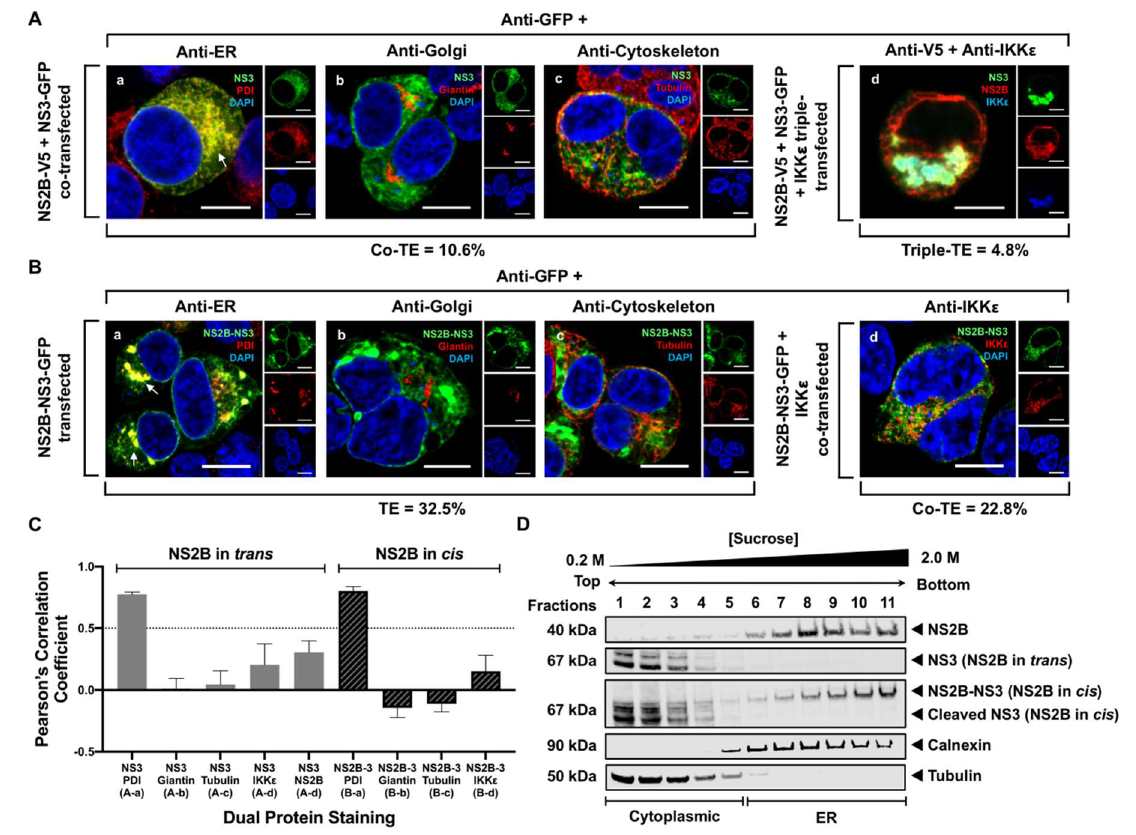
Figure 3. NS3 localizes to the ER when NS2B is provided in trans and in cis. ( A ) HEK293T cells were co-transfected with NS3-GFP and NS2B-V5 expressing plasmids ( a – c ). At 24 h post-transfection, cells were fixed and co-stained with anti-GFP and antibodies against PDI (red; a ), giantin (red; b ) or tubulin (red; c ). HEK293T cells were also triple-transfected with NS3-GFP, NS2B-V5/His and IKK ε -FLAG expressing plasmids ( d ) and triple stained with anti-GFP (green; d ), anti-V5/His (red; d ) and anti-IKK ε (blue; d ) antibodies. ( B ) HEK293T cells were transfected with NS2B-NS3-GFP ( a – c ) or co-transfected with NS2B-NS3-GFP and IKK ε -FLAG expressing plasmids ( d ) and processed for immunofluorescence at 24 h after transfection using antibodies against PDI (red; a ), giantin (red; b ), tubulin (red; c ) and IKK ε (red; d ). The detected viral and host proteins are listed on the top right corner of each panel. White arrows indicate colocalization between the GFP-tagged viral protein and the ER marker. Nuclear DNA was labeled with DAPI. Scale bar represents 10 μm. The main panels depict merged images with the side panels showing the individual channels. The transfection efficiency (TE), the co-transfection efficiency (Co-TE) and the triple-transfection efficiency (Triple-TE) for cells expressing one, two, or three gene constructs, respectively, are listed at the bottom of the panel. Images are representative of two independent transfection experiments. ( C ) Quantitation of colocalization between NS3 and cellular markers when NS2B is provided in trans (gray bars) or in cis (diagonally striped bars) was determined using the Pearson’s correlation coefficient (PCC). Letters in parenthesis underneath each pair of proteins indicate its corresponding confocal image in Figure 3A or 3B. PCC values greater than 0.5 (dotted line) indicate a high level of colocalization. Error bars indicate mean ± SEM; n = 5–10 cells per group. (D) HEK293T cells expressing both NS3-V5 and NS2B-GFP with NS2B provided in trans or cells expressing NS2B-NS3-GFP with NS2B provided in cis were lysed 48 h post-transfection and subjected to sucrose density gradient ultracentrifugation. Aliquots of fractions collected from the top of the gradient were analyzed by Western blotting. Rabbit anti-tubulin and anti-calnexin antibodies were used to distinguish between the cytoplasmic and ER fractions, respectively, and antibodies against the fused tag (GFP or V5/His) were used to detect the viral protein.